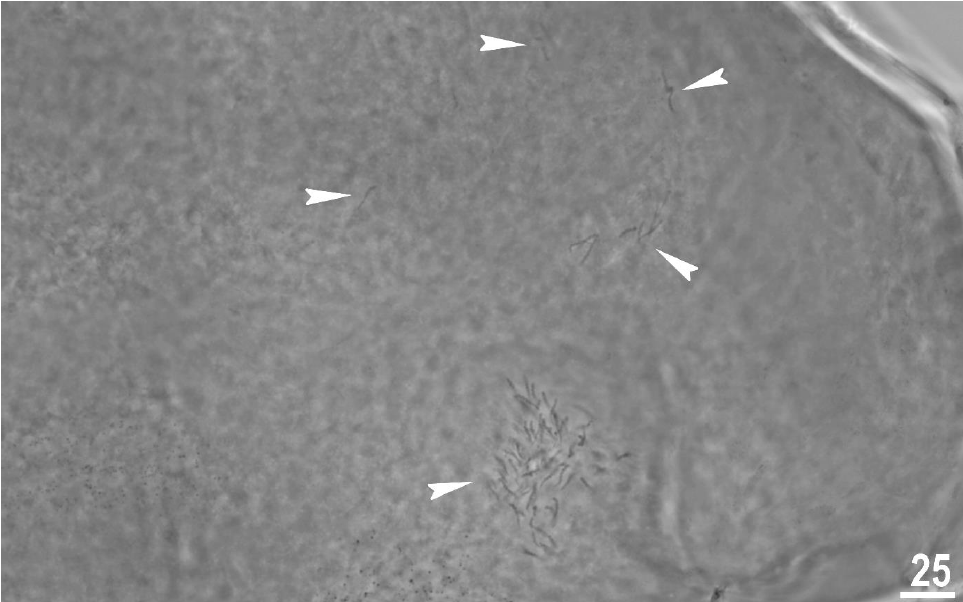
Figure 9. Macrobiotus rebecchii sp. nov. reproduction. Ovotestis filled with fully developed smerma- tozoa indicated by the filled indented arrowheads. Scale bar in μm.